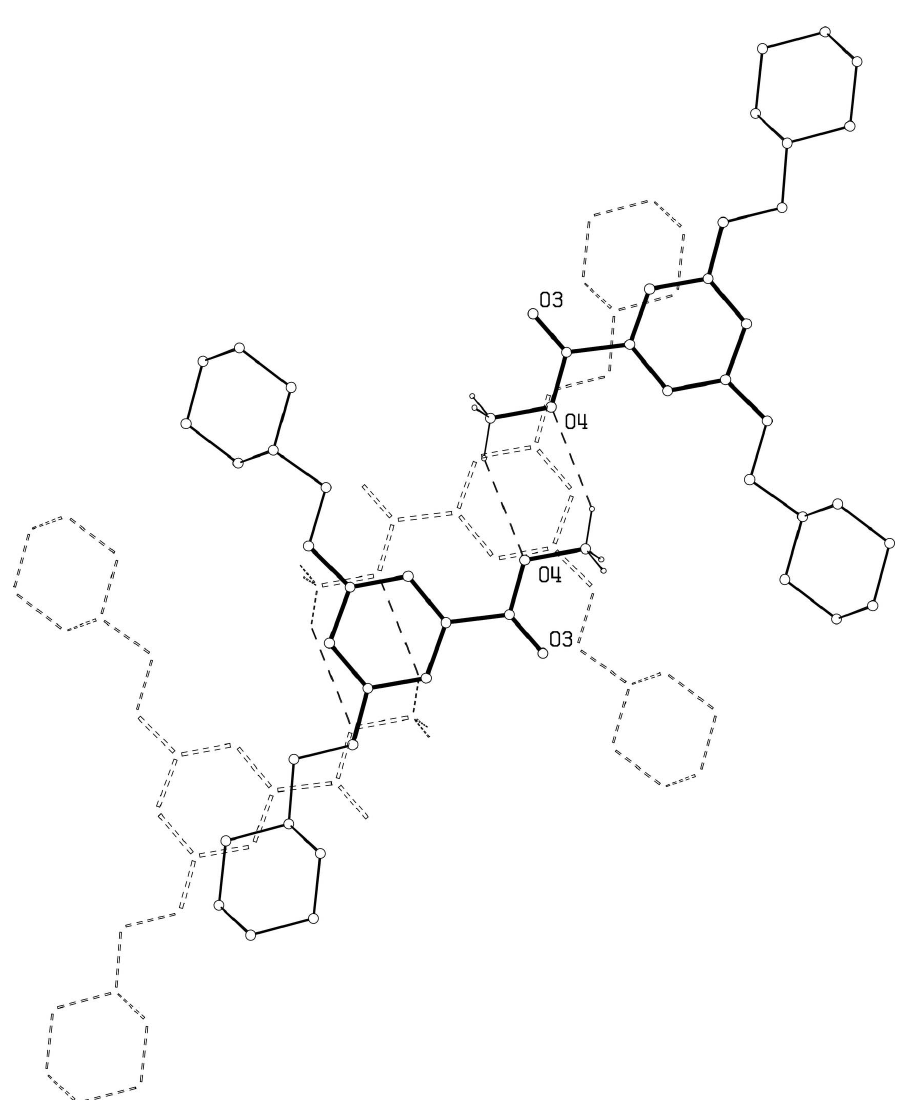
Figure 3 View of the hydrogen-bonded pair of molecules perpendicular to the central molecular plane. The dashed molecules represent a molecular pair unit translated by - a